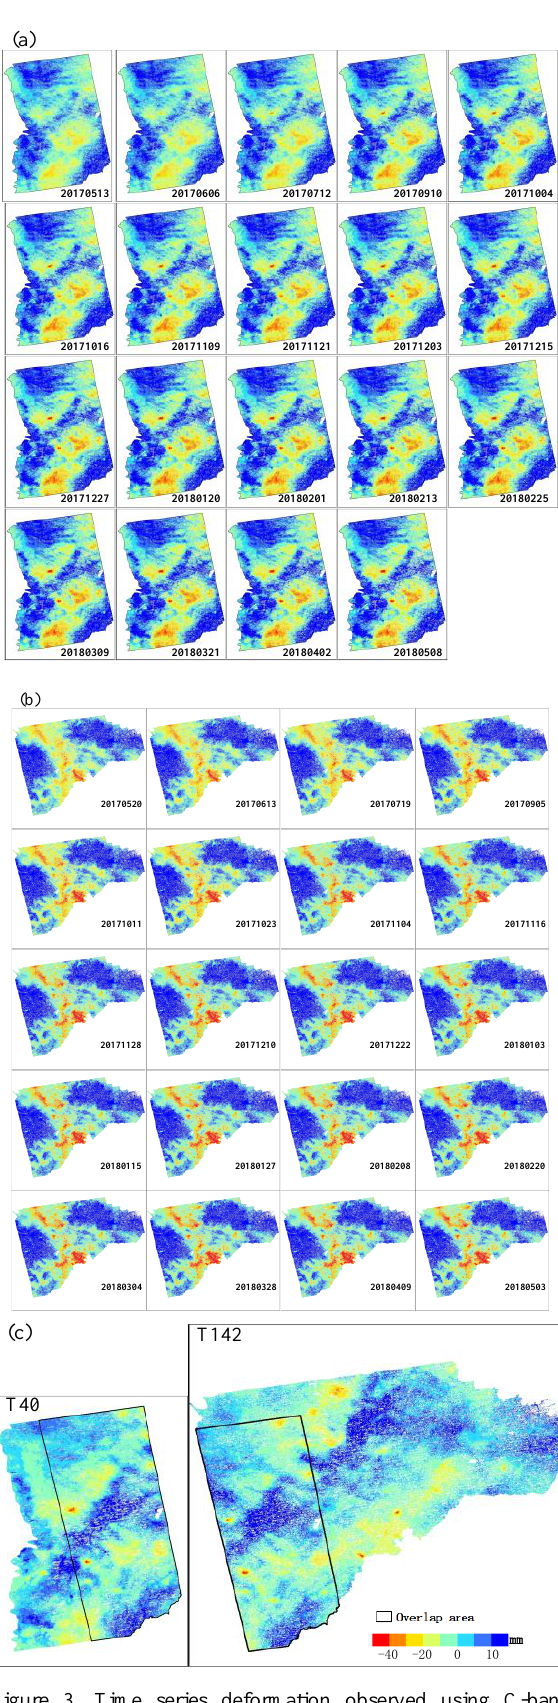
Figure 3. Time series deformation observed using C-band Sentinel-1A images with ascending orbit between May